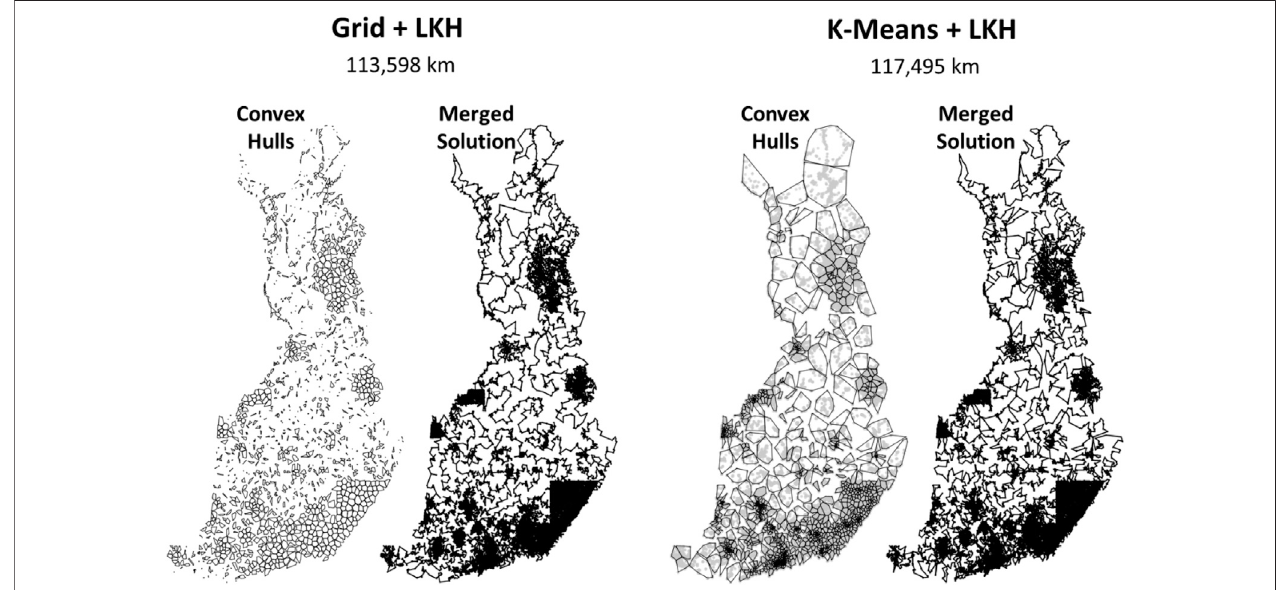
FIGURE 19 | Solutions after solving individual clusters and merging the subtours. The convex hulls of the clusters are given for reference. On the right, data points are also shown to highlight the patterns.